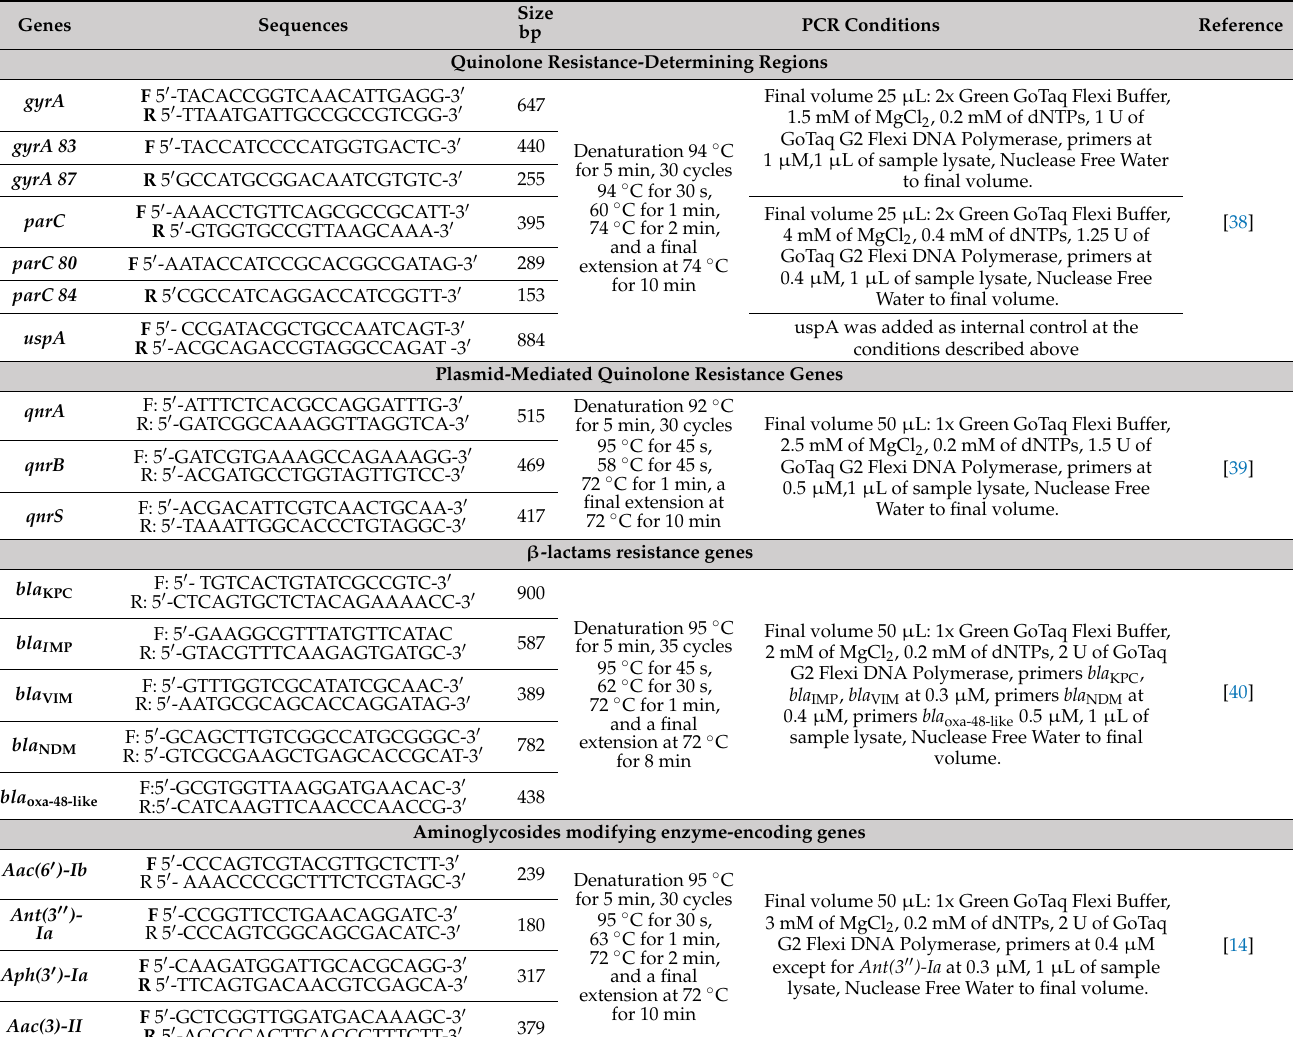
Table 1. Oligonucleotide primers and PCR conditions used in this